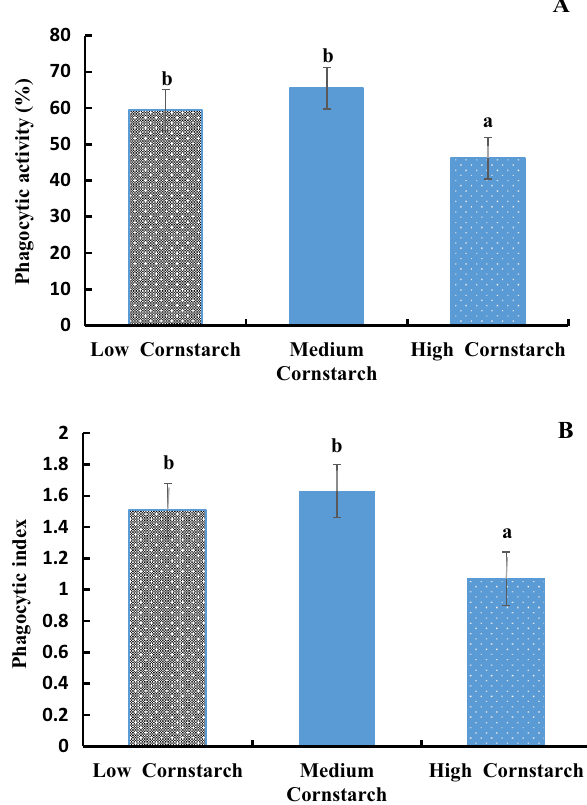
Figure 2. ( A ) Phagocytic activity of leucocytes in tilapia, Bars with different letters are significantly different ( P < 0.05). ( B ). Phagocytic index of leucocytes in tilapia, Bars with different letters are significantly different ( P < 0.05). Phagocytosis percentage = no. of ingesting phagocytes/total no. of phagocytes; Phagocytic index = no. of ingested yeast cells/no. of ingesting phagocytes.